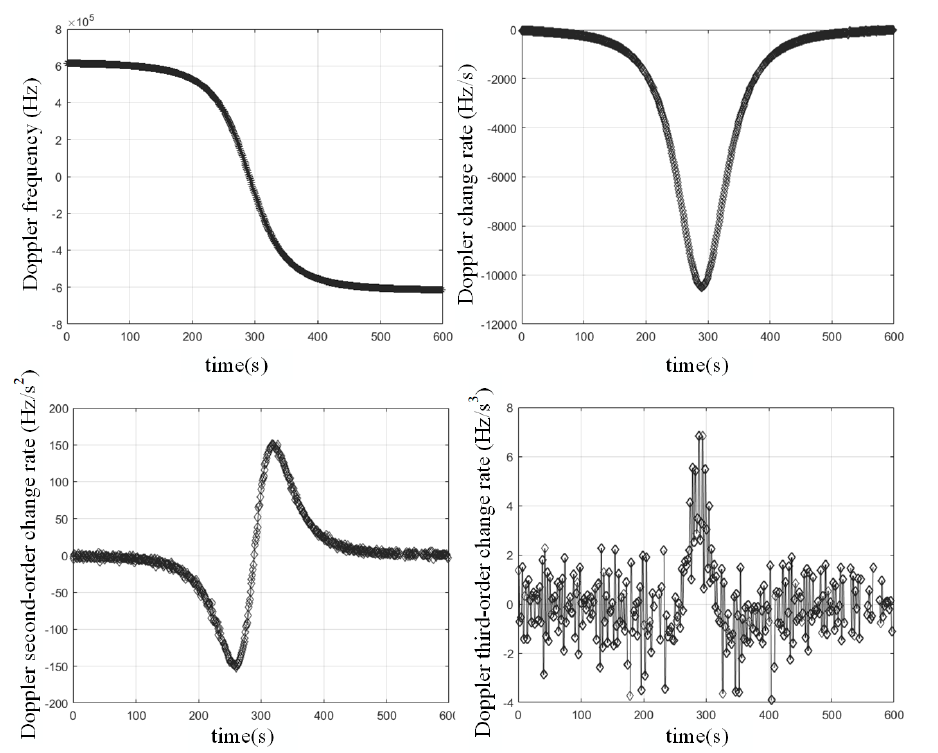
Figure 2. Carrier dynamics of the spread spectrum signal, including Doppler frequency, Doppler change rate, Doppler second-order change rate, and Doppler third-order change